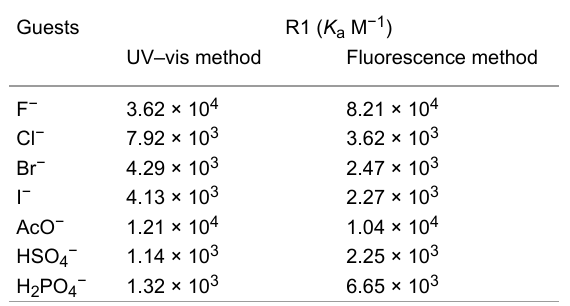
Table 1: Association constants a of receptor 1 (R 1 ) with [Bu 4 N] + X − salts (X = F − , Cl − , Br − , I − , AcO − , HSO 4− , and H 2 PO 4− ) in CH 3 CN/H 2 O (4:1 v/v) determined by UV–vis and fluorescence